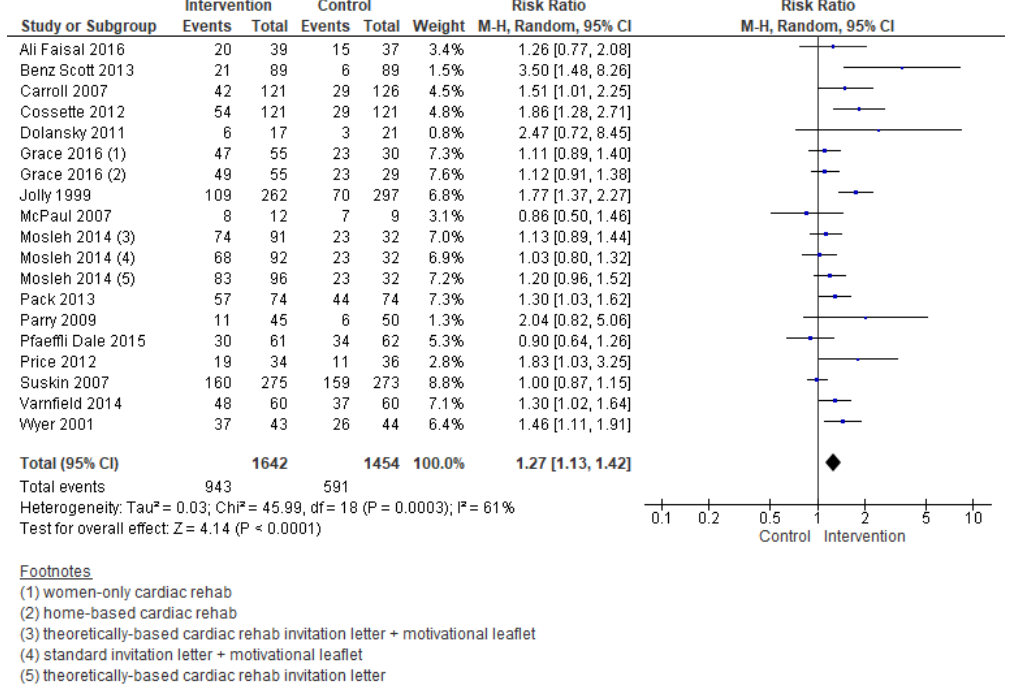
Figure 3. Forest plot summarizing the effect of cardiac rehabilitation utilization interventions on enrollment. Note: Boxes represent the risk ratio (RR) for individual trials. The boxes are proportional to the weight of each study in the analysis and the lines represent their 95% confidence interval (CI). The diamond represents the pooled RR, and its width represents its 95% CI. M-H: Mantel Haenszel method. Tau 2 represents the variance of the effect size across studies. Chi 2 (Cochran Q test) represents the weighted sum of squared differences between individual studies and the pooled effect across studies. I 2 statistic represents the percentage of variation across studies that is due to heterogeneity. Z represents the test for overall effect across all studies. df: degrees of freedom.